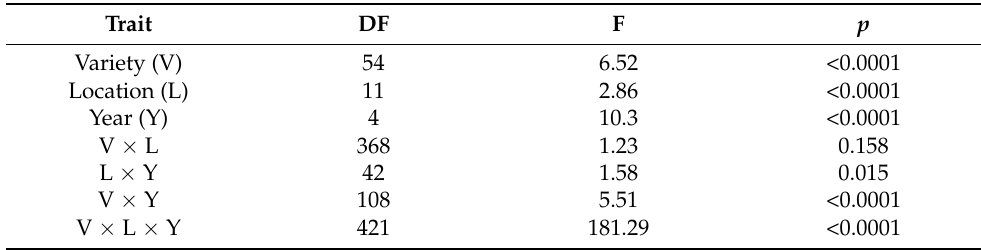
Table 4. F statistics for variety, location, year and their interaction effects on sugarcane yellow leaf virus